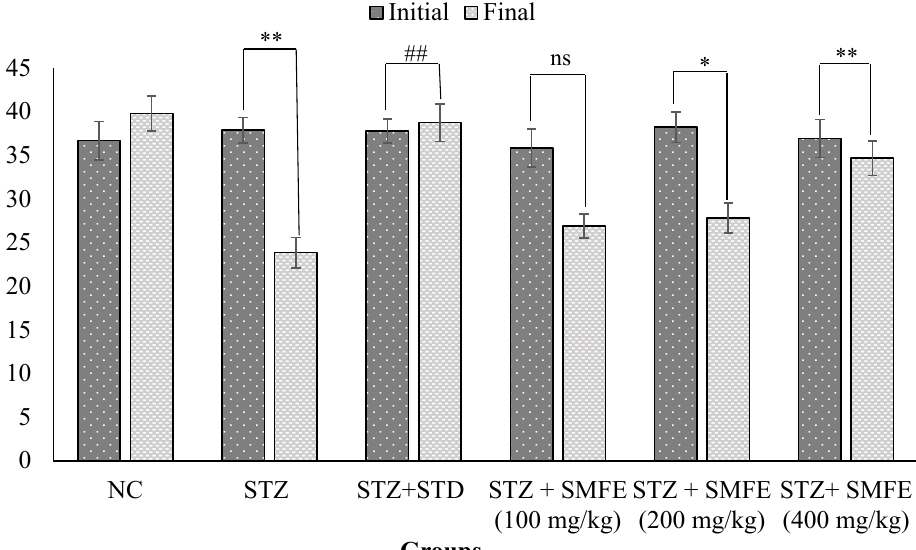
Figure 9. Effects of SMF extract and glibenclamide on body weight in mice. Data are represented as the mean ± SEM ( 𝑛 = 6). ** p < 0.01 = significant when compared with diabetic control group normal mice. * p < 0.05 and ## p < 0.01 = significant when compared with diabetic control. ns p > 0.05 = non-significant when compared with diabetic control. NC = normal control; STZ = streptozotocin; SMFE = S. mangifera fruit extract; STD = standard drug (glibenclamide).